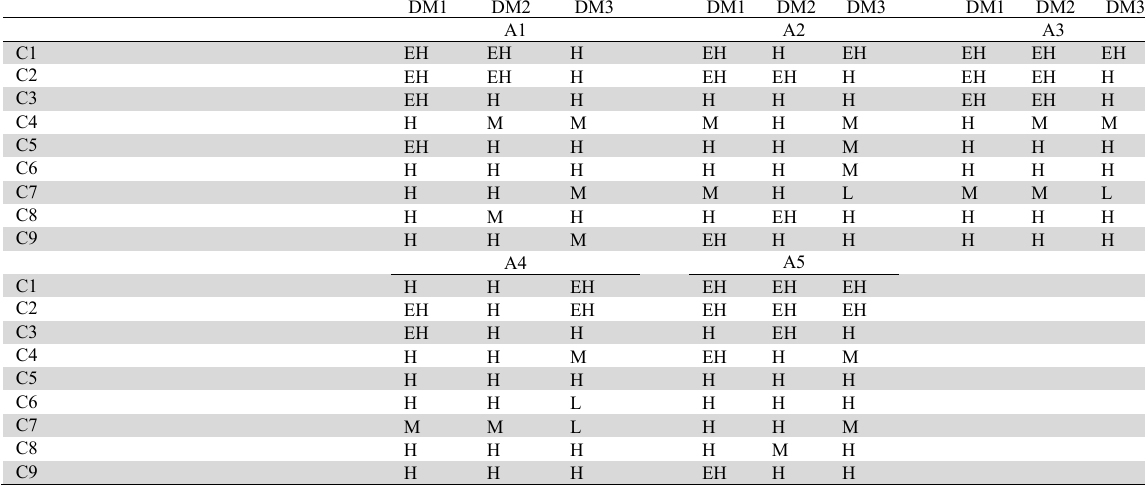
Rating of the measures with linguistic